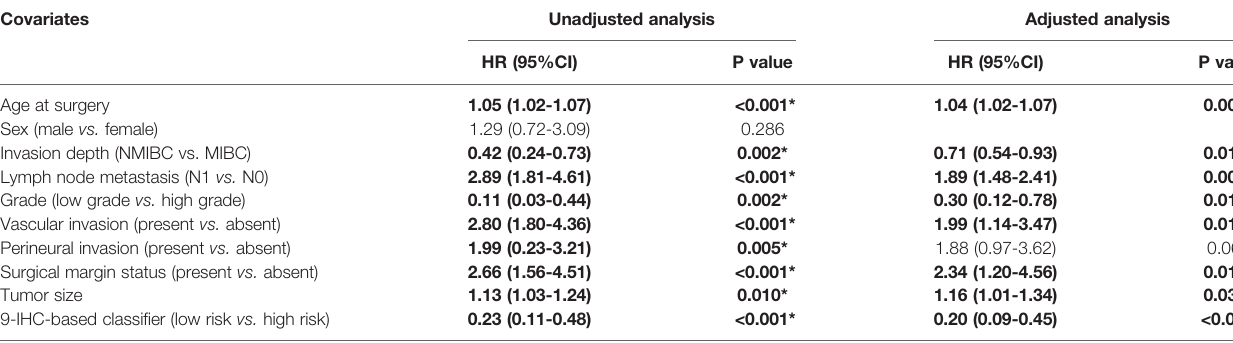
TABLE 2 | Unadjusted and adjusted Cox regression analyses of DFS in bladder cancer patients.